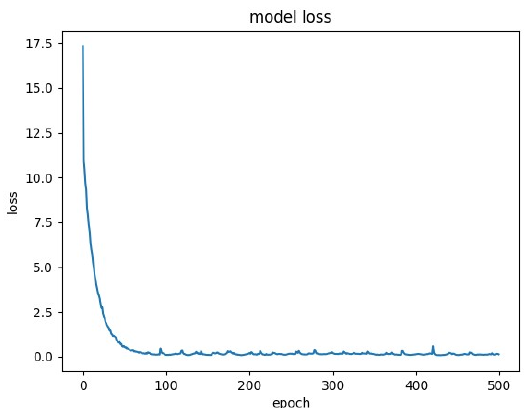
Figure 3. Loss plot for baseline model with 3000 samples, 500 epochs.